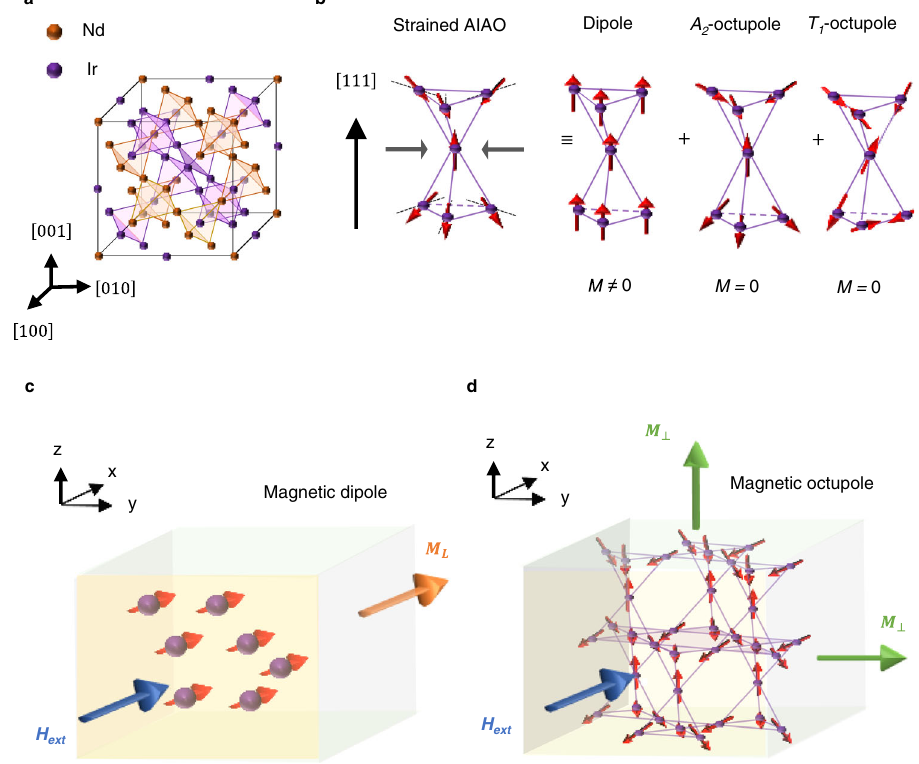
Fig. 1 | Schematic diagram of strain-induced cluster magnetic multipoles and OM in Nd 2 Ir 2 O 7 thin fi lms. a Schematic view of the pyrochlore lattice structure of Nd 2 Ir 2 O 7 . b When compressive strain is applied to Nd 2 Ir 2 O 7 along the [111] direc- tion, the AIAO con fi guration of the magnetic spin experiences spin canting. Such canting can be represented by three distinctive magnetic multipoles (dipole, A 2 - octupole, and T 1 -octupole). Note that the dipole has fi nite magnetization, whereas